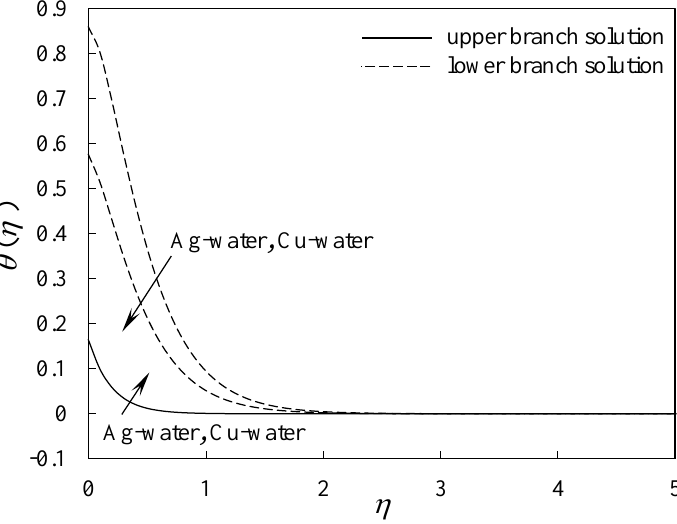
Figure 21. Velocity profiles h (cid:48) ( η ) when λ = − 1, N = 1, K = 1, and M = 1. Appl. Sci. 2018 , 8 , x FOR PEER REVIEW